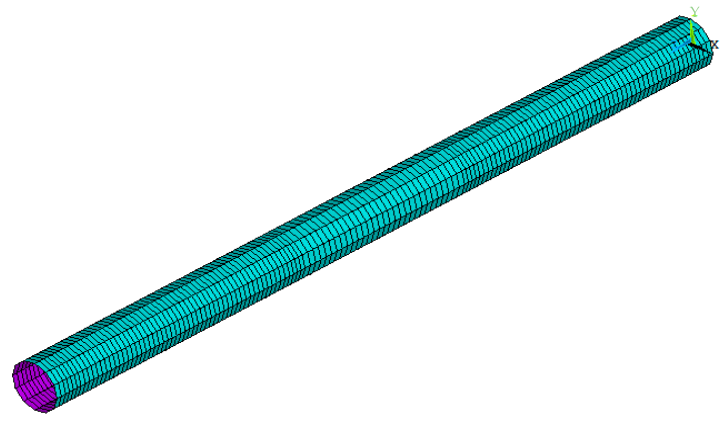
Figure 5. Modeling and meshing of the steel circular hollow specimens.